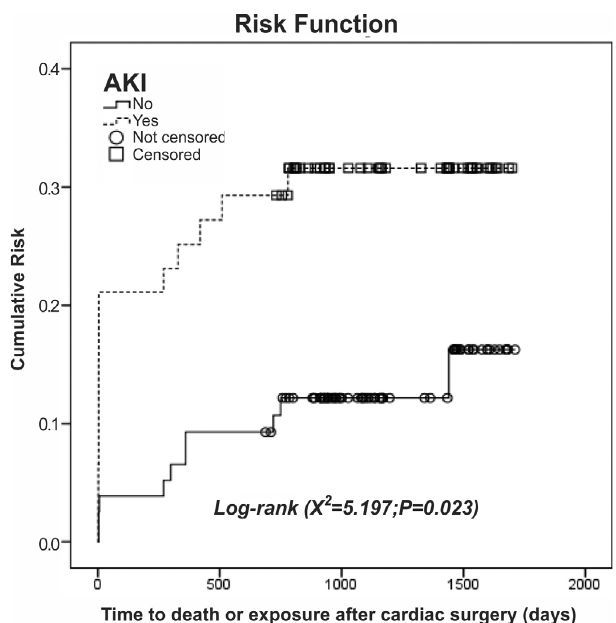
Fig. 2 - Analysis of early mortality among individuals with and without acute kidney injury (AKI) after cardiac surgery.